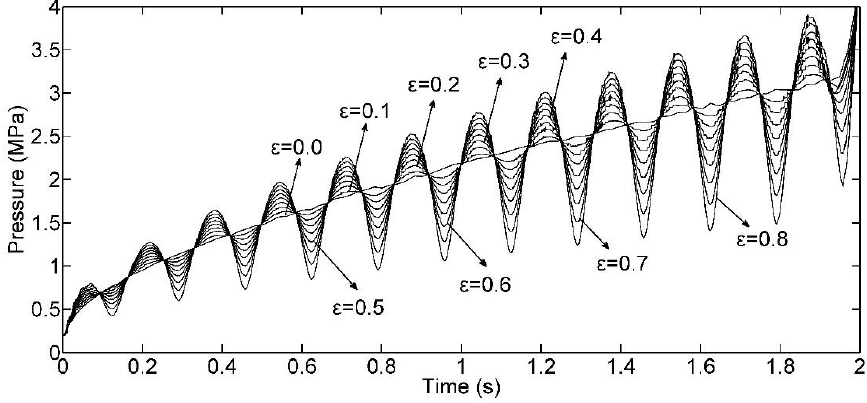
Figure 6. Injecting pressure curves with different ε .